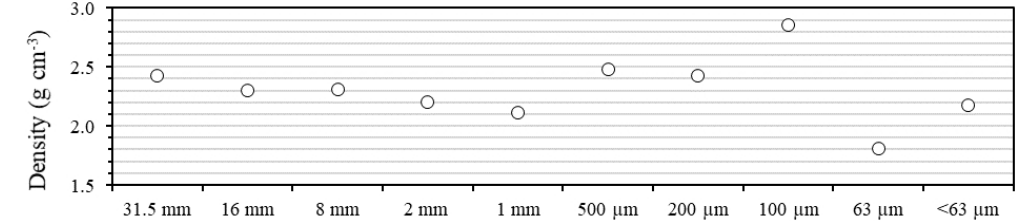
Figure 5. The Orne riverbed sediment density measured for each of the 10 sediment size classes.